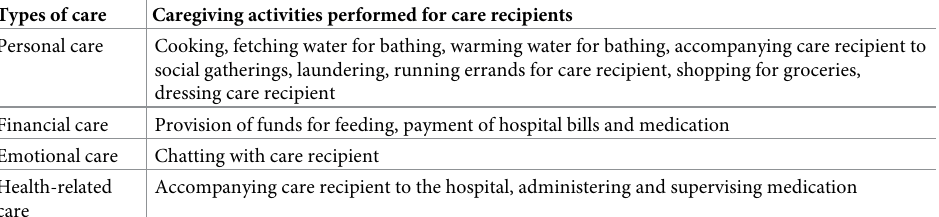
Table 2. Types of care provided by family